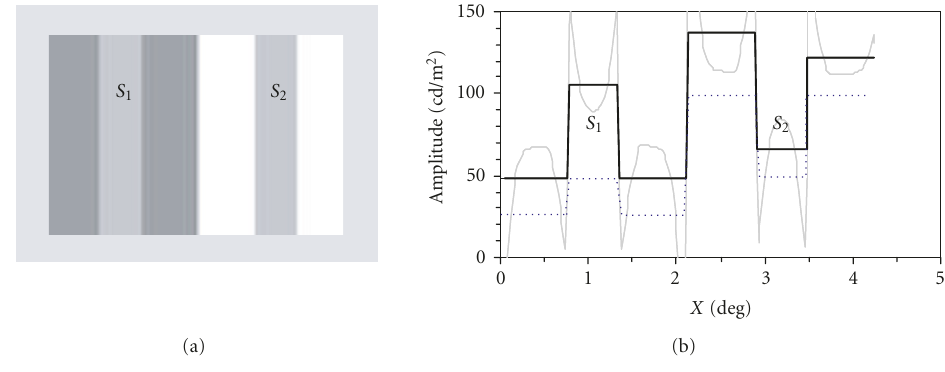
Figure 5: Panel (a) is a demonstrative pattern to show the e ff ect of simultaneous contrast, where stripe S 1 looks brighter than S 2 while they have the same luminance, and panel (b) shows the luminance profile of the visual pattern (dotted lines) and the model simulation results of the brightness before (dim lines) and after (thick lines) a fill-in